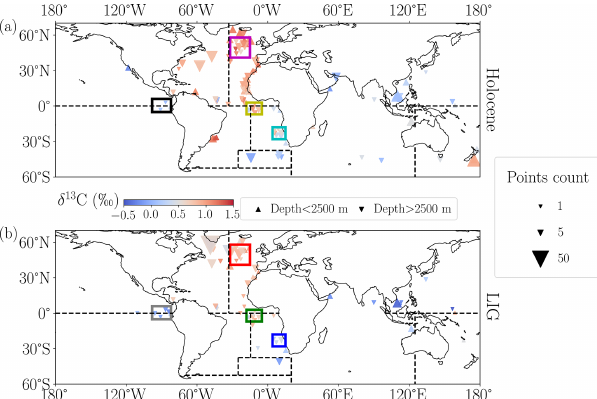
Figure 2. Global distribution of benthic foraminifera δ 13 C cov- ering the periods studied here: the Holocene (7–2kaBP) (a) and LIG (125–120kaBP) (b) . Symbol size indicates the number of val- ues per core, colour indicates average δ 13 C, and the triangle di- rection indicates the proxy depth (upward-pointing triangle: be- tween 1000 and 2500m depth; downward-pointing triangle: deeper than 2500m). Four specific regions used in Sect. 3.1 are outlined: eastern equatorial Pacific (black, grey), equatorial Atlantic (yellow, green), southeastern Atlantic (cyan, blue), and northeastern Atlantic (magenta, red). Regional boundaries used to calculate the global volume-weighted mean δ 13 C (Sect. 3.2) are indicated by dotted black lines as defined in Peterson et al. (2014).